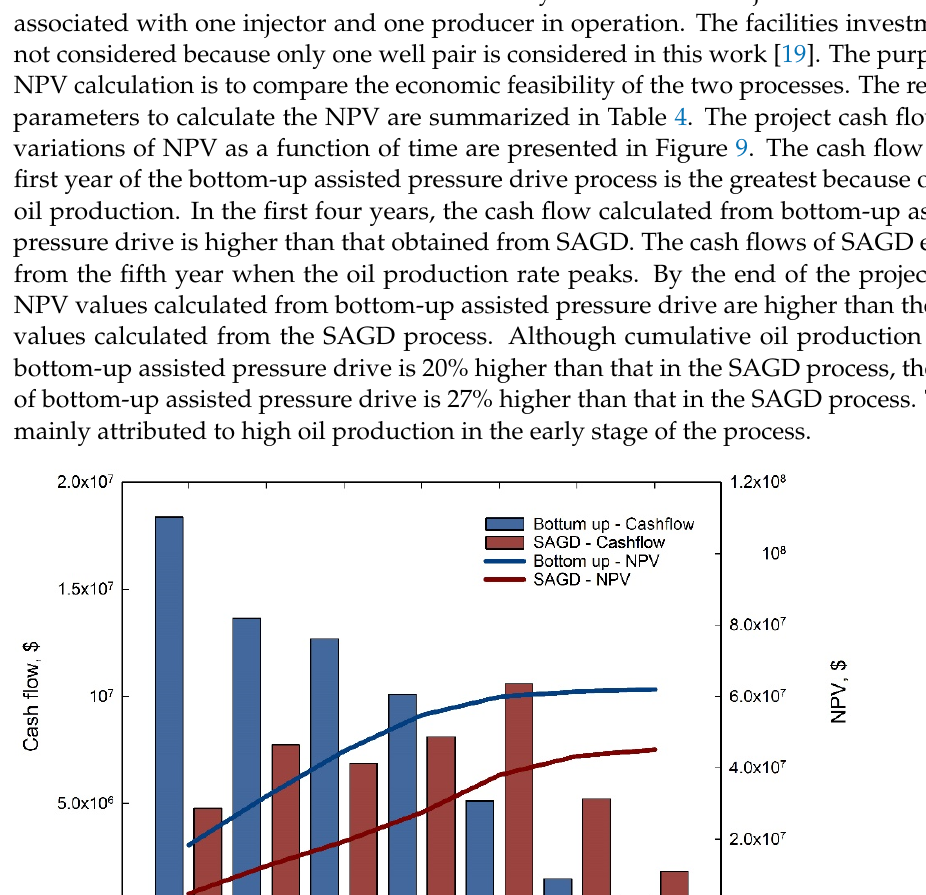
Table 4. The relevant parameters for the NPV calculation.